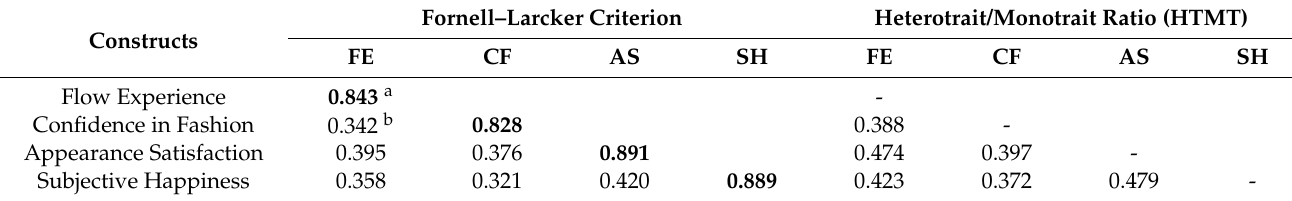
Table 2. Assessment of discriminant